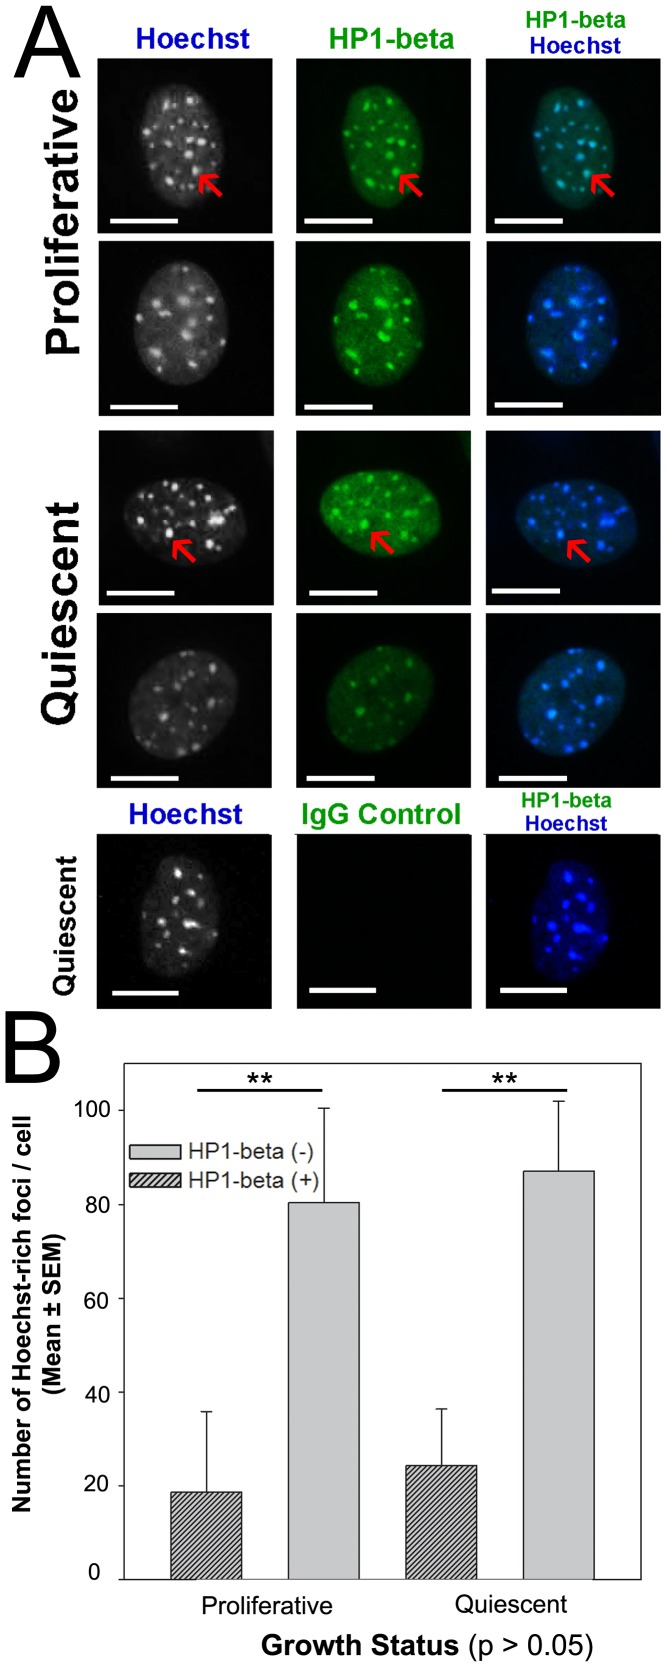
The effect of cell growth on the pattern of co-staining for heterochromatin (HP1-β) and bisBenzimide (Hoechst 33342).
A co-staining of HP1-β (and non-immune IgG control) and Hoechst in proliferative and quiescent cells. Scale bar 10 micron. B The number of Hoechst-dense foci co-stained with HP1-β (+) or not (−). HP1-β co-localized with Hoechst foci (p<0.01) irrespective of cell proliferation (p>0.05). Mean + i.e. The results are of three independent replicates. ** p<0.01.